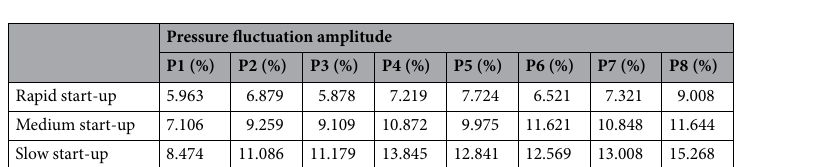
Figure 14. Frequency domain diagrams of different monitoring positions in the volute. ( a ) Rapid, ( b ) Medium, ( c ) Slow.